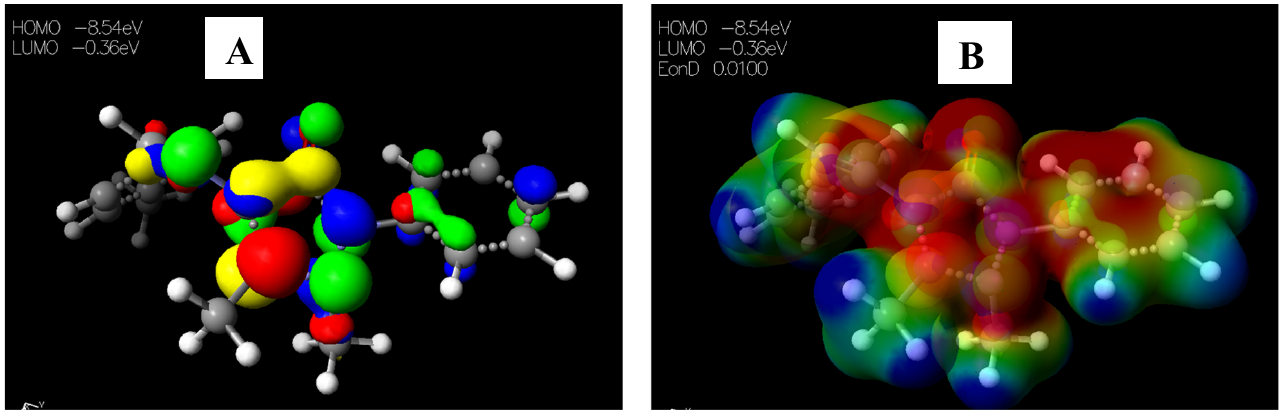
Figure 7. Images showing the ( A ) Highest occupied molecular orbital (HOMO) and Lowest unoc- cupied molecular orbital (LUMO) and ( B ) Molecular electrostatic potential (MESP) plots of 3.